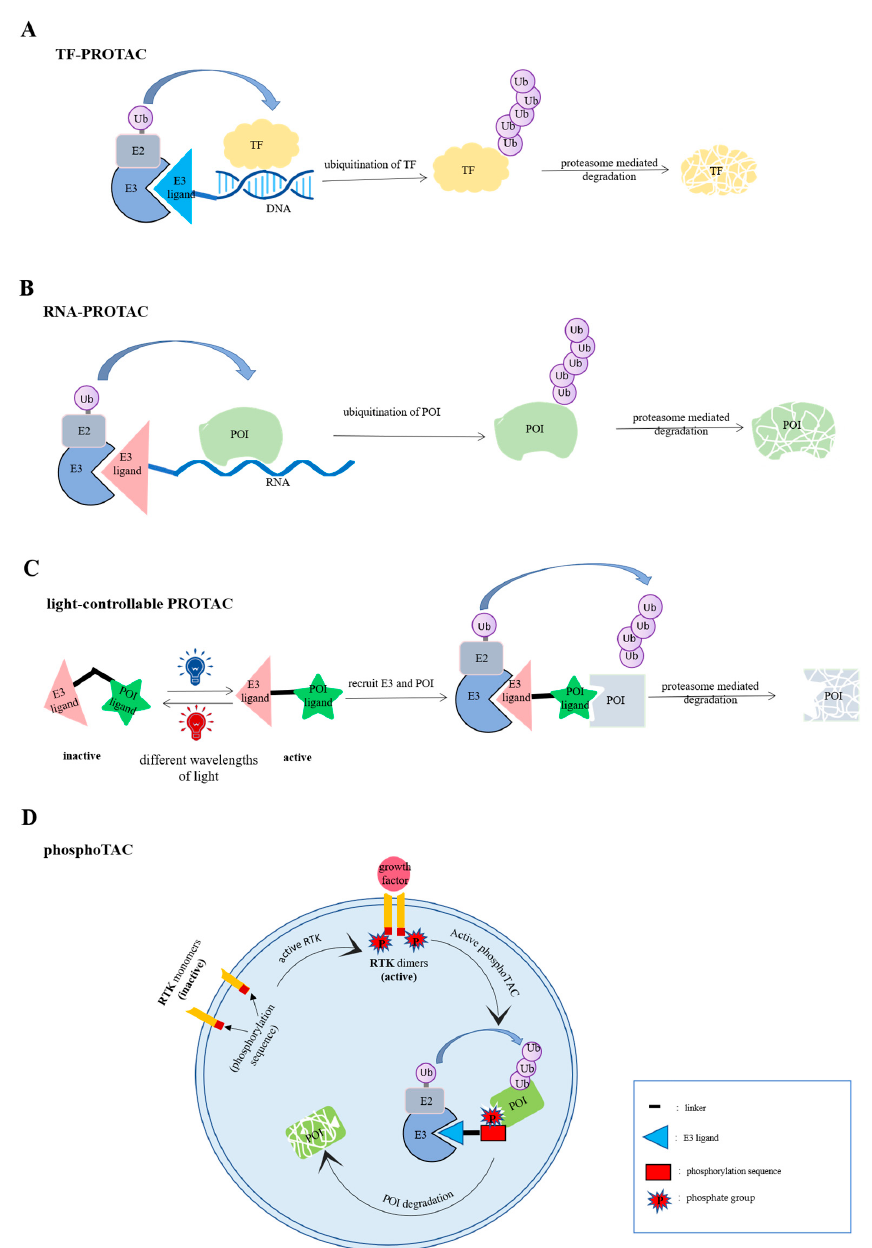
Figure 2. Schematic diagram of targeted degradation strategies based on ubiquitin-proteasome system (UPS). ( A ) The DNA sequence of TF-PROTAC selectively binds to transcription factor (TF), whereas E3 ligase ligand specifically recruits E3 ligase. Finally, TF is ubiquitinated by E3 ligase and degraded by the proteasome. ( B ) RNA-PROTAC binds to POI via RNA sequence, and recruits E3 ligase specifically by E3 ligase ligand. After being modified by ubiquitination, POI is degraded by the proteasome. ( C ) Light-controllable PROTAC photochemically isomerize upon irradiation with different wavelengths of light. Therefore, the PROTAC can be reversibly active or inactive. Only when PROTAC is activated by a specific wavelength of light, it can degrade POI. ( D ) RTK monomers are inactive. When RTK is activated by growth factor, in addition to dimerization and autophosphorylation, RTK can also induce PhosphoTAC activation, which enables phosphoPROTACs to recruit POI and E3 ligase, and ultimately leads to ubiquitination and degradation of